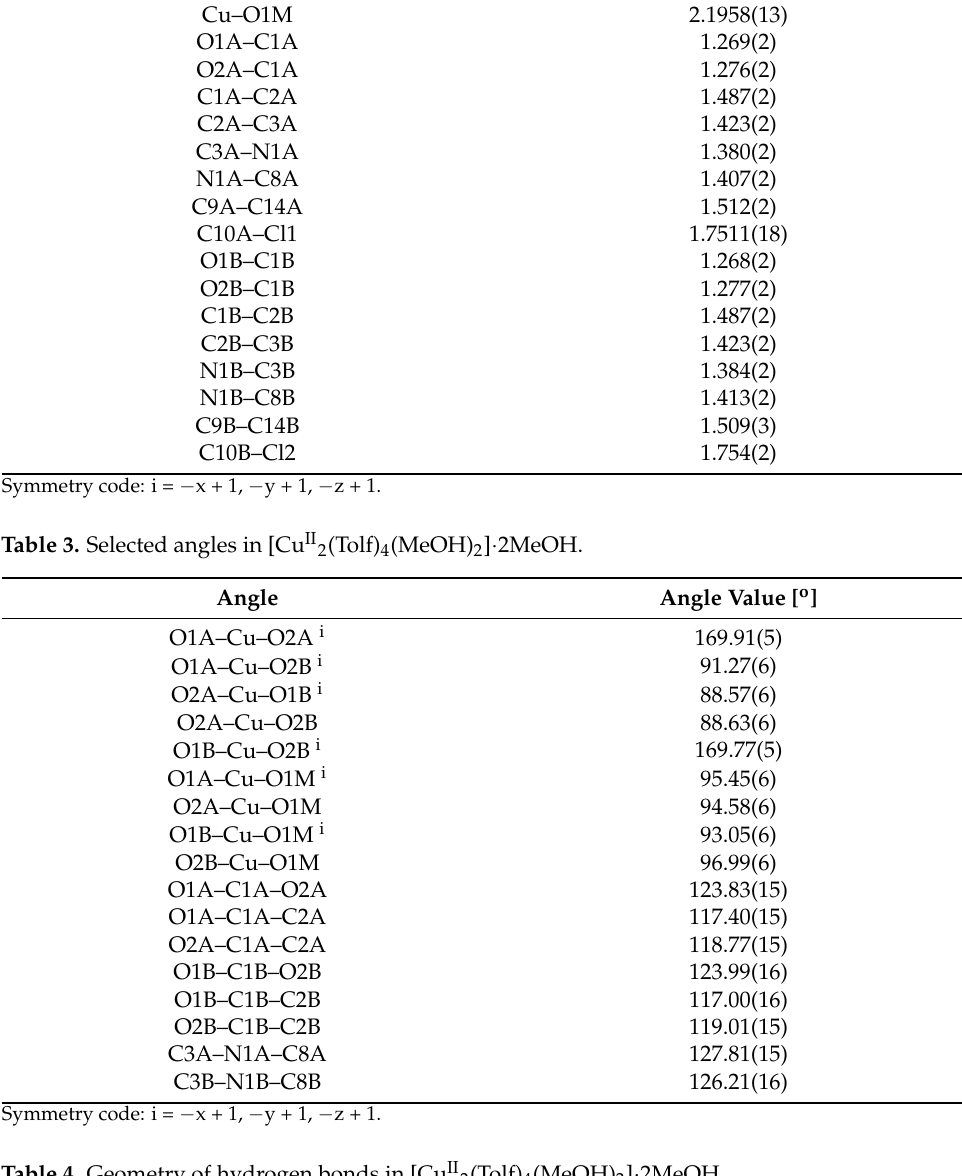
Table 4. Geometry of hydrogen bonds in [Cu II 2 (Tolf) 4 (MeOH) 2 ] ·